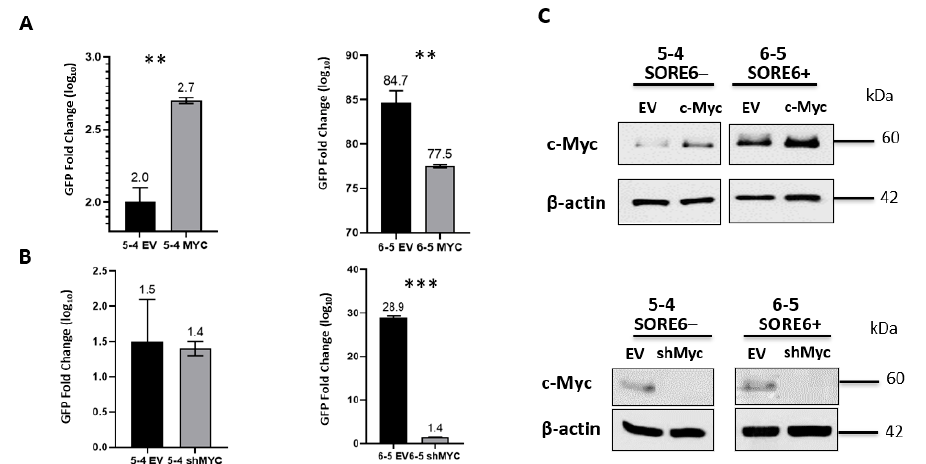
Figure 7. c-Myc regulates the GFP activity of SORE6 clones. ( A ) FACS analysis of GFP activity following overexpression of c-Myc in 5-4 (SupM2 SORE6 − clone) and 6-5 (SupM2 SORE6+ clone). ( B ) FACS analysis of GFP activity following downregulation of c-Myc in 5-4 (SupM2 SORE6 − clone) and 6-5 (SupM2 SORE6+ clone). ( C ) Western blot indicating successful transfection of c-Myc or shRNA for Myc for both experiments are included in the panels to the right. Results are mean ± SEM, ** p < 0.01, *** p < 0.001. Of note, the c-Myc band for the SORE6 − cells treated with shRNA for c-Myc (Figure 7C, bottom-left corner) was intentionally over-exposed to reveal the otherwise weak c-Myc band.